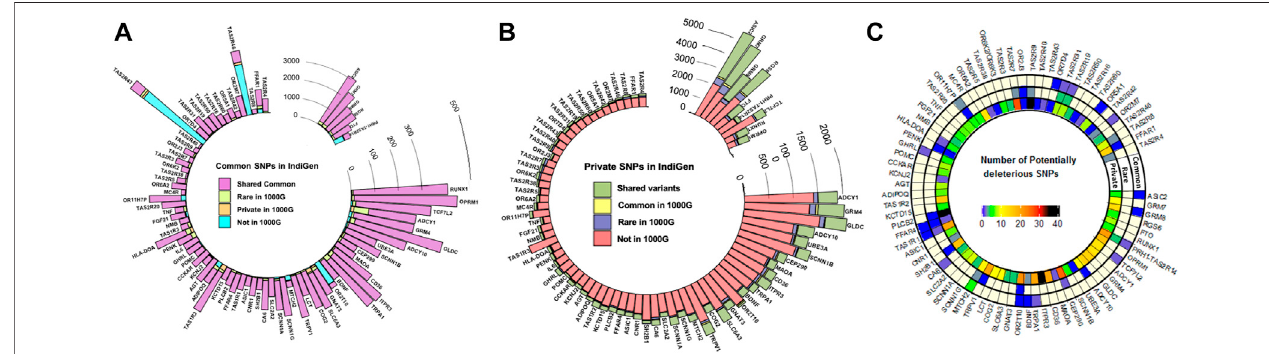
FIGURE 1 | Comparison of the frequency distribution of variants across the genes in IndiGen and the 1000 Genomes Project (1000G) (A) Number of SNPs with a common frequency in IndiGen (B) Number of private SNPs in IndiGen and their frequencies in other populations of the 1000G — The same frequency category as in IndiGen or higher/lower frequencies than in IndiGen (C) The numbers of potentially deleterious variants across the genes. The genes are ordered by size from largest to smallest (clockwise).